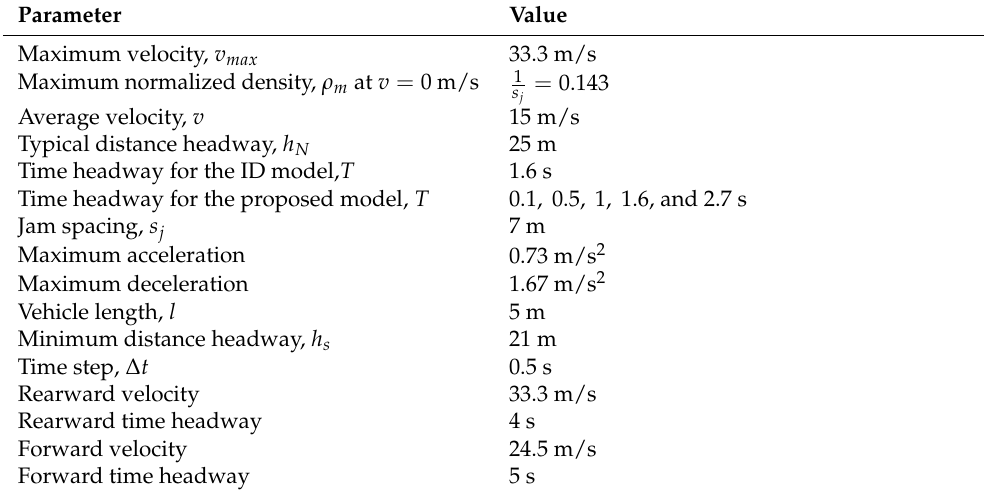
Table 2. Simulation Parameters.